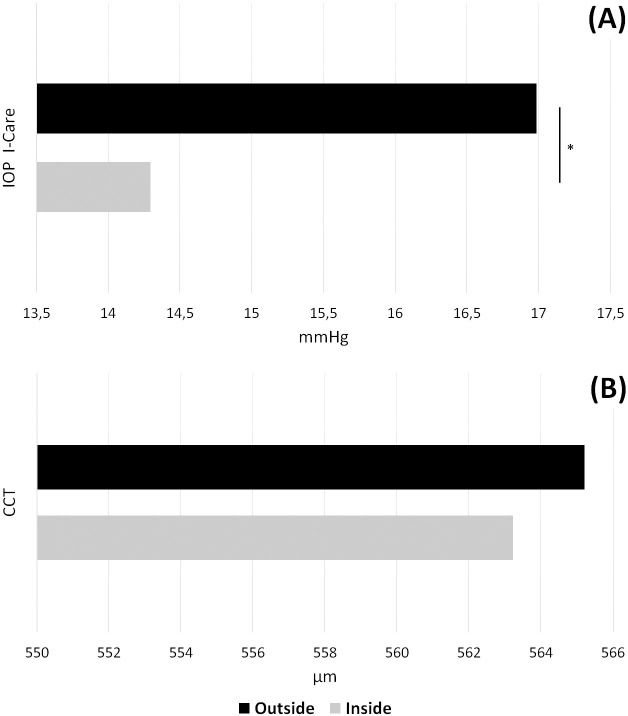
Effect of sub-zero temperature on intra ocular pressure and central corneal thickness.Comparison of intraocular pressure and central corneal thickness at Pointe Helbronner (3,466 m above sea level) measured in a closed environment (19°C) and in the open air (-1°C). Outside values are represented with black bars and inside values are represented with light grey bars. Statistics found no difference in CCT, but a significant effect of cold on IOP. *P-value indicates a statistically significant difference (p<0.05).